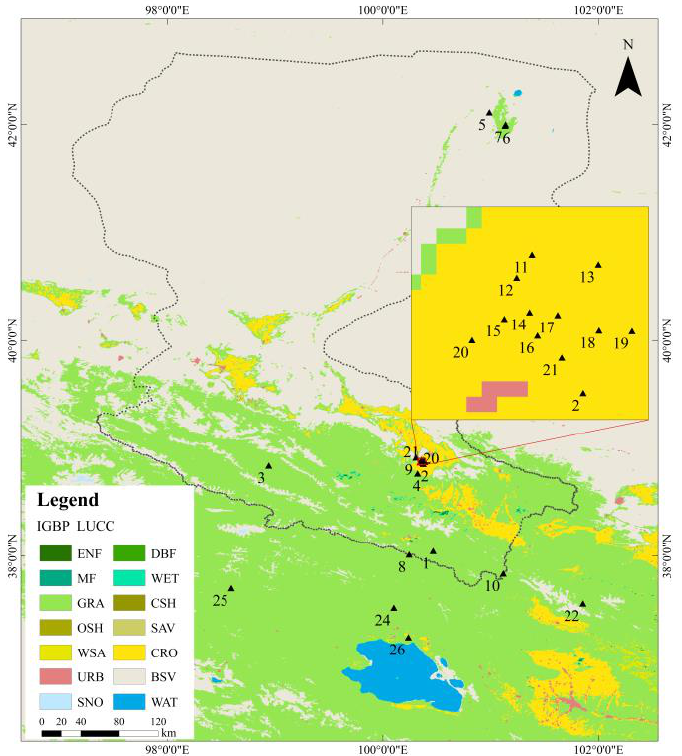
Figure 1. Land cover and flux tower site locations of the HRB. ENF—evergreen needleleaf forest; DBF—deciduous broadleaf forest; MF—mixed forest; WET—permanent wetlands; GRA—grasslands; CSH—closed shrublands; OSH—open shrublands; SAV—savannas; WSA—woody savannas; CRO—croplands; URB—urban and built-up; BSV—barren or sparsely vegetated; SNO—snow and ice; WAT—water